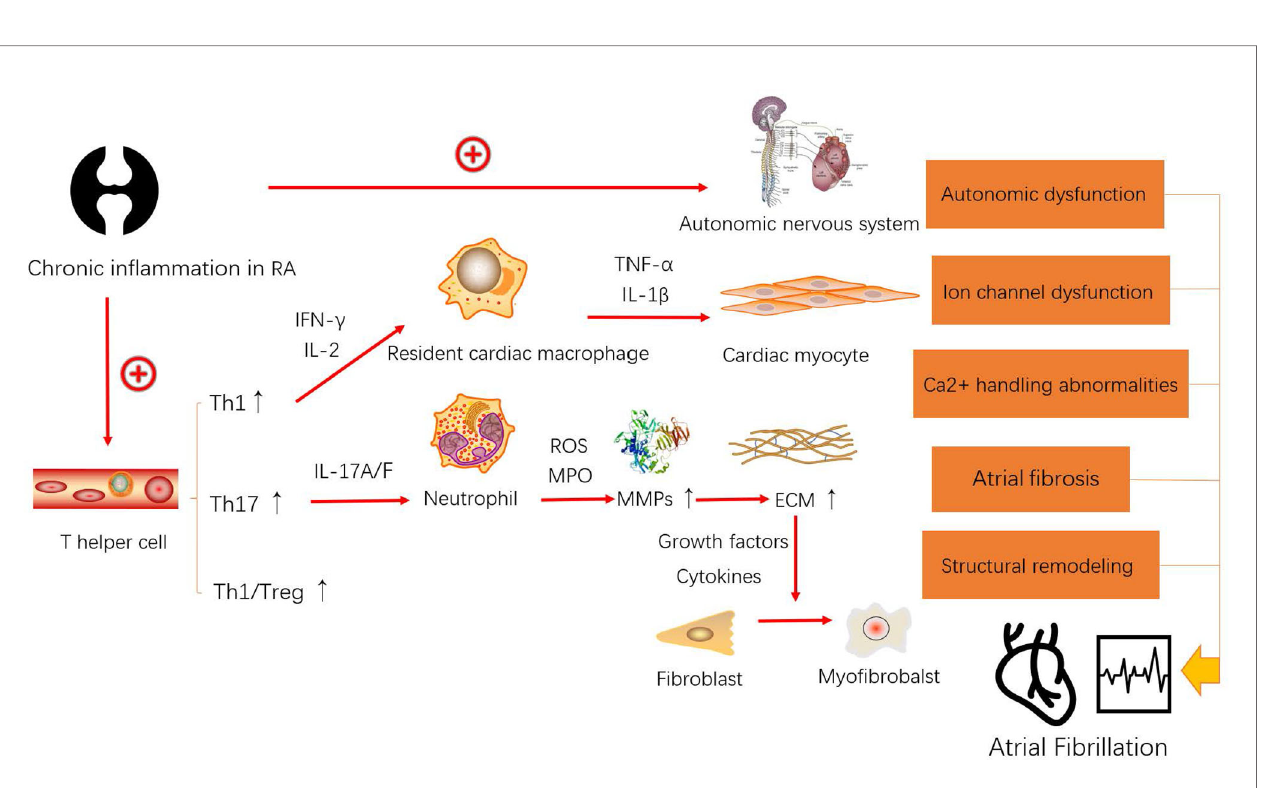
FIGURE 3 | Model of the possible mechanism leading to the occurrence and development of atrial fi brillation (AF) caused by rheumatoid arthritis